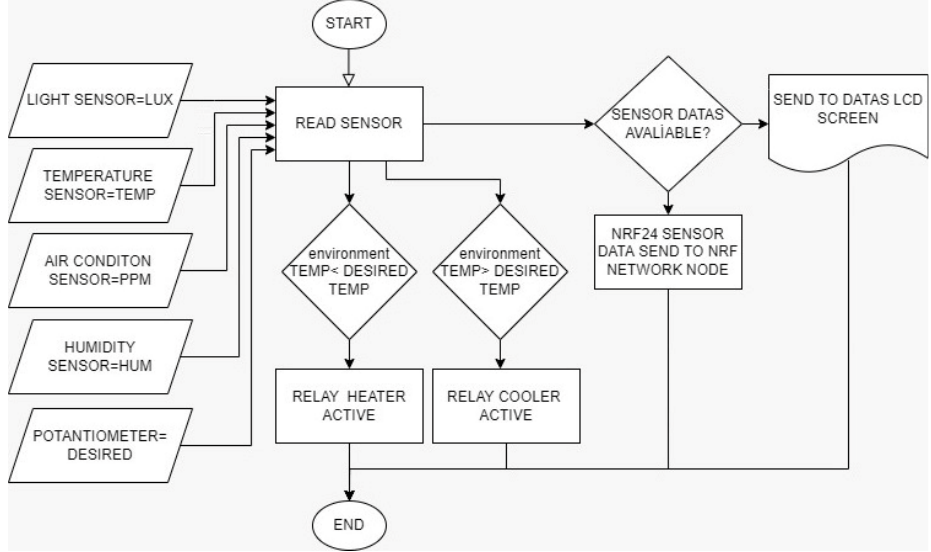
Figure 5. The basic algorithm of the software of the data box.